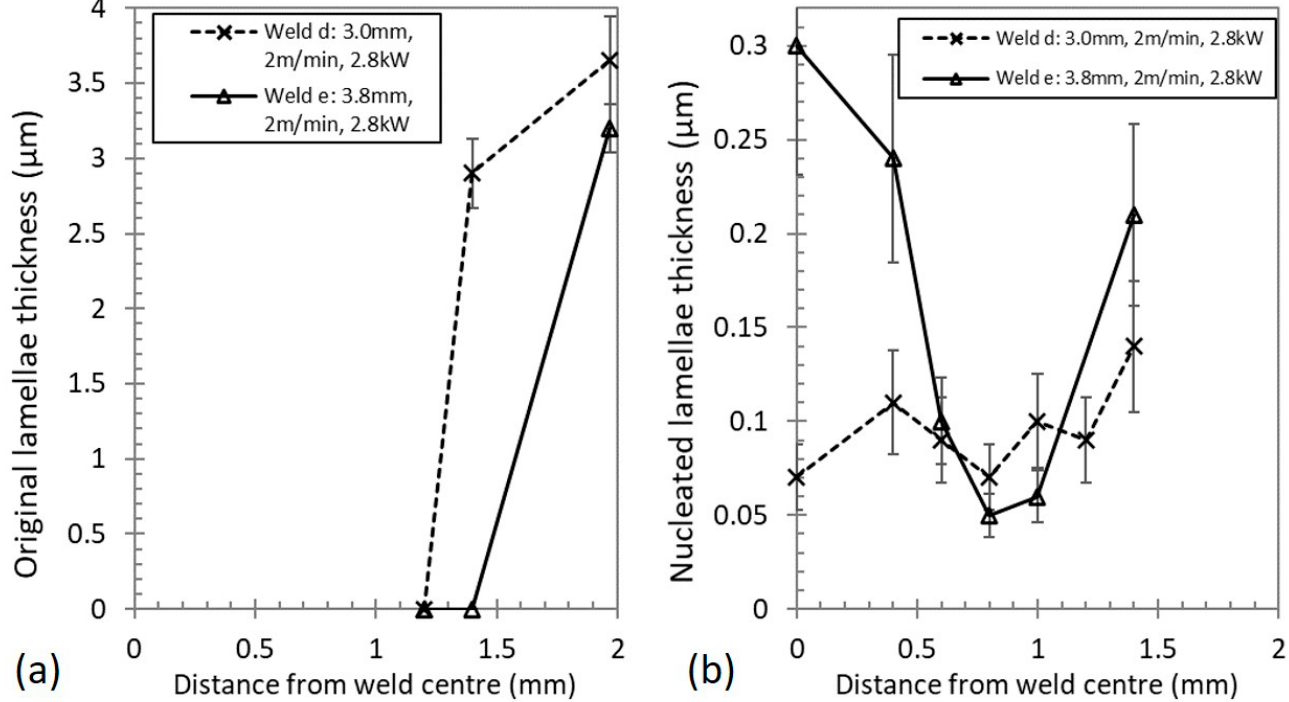
Figure 9 . The experimentally measured ( a ) original lamellae thickness and ( b ) nucleated lamellae thickness after welding in plates with an initially lamellar morphology .